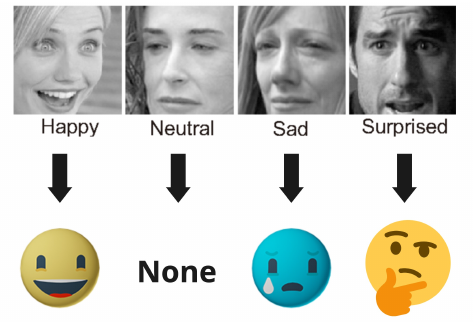
Figure 5. Mapped emojis for each emotion